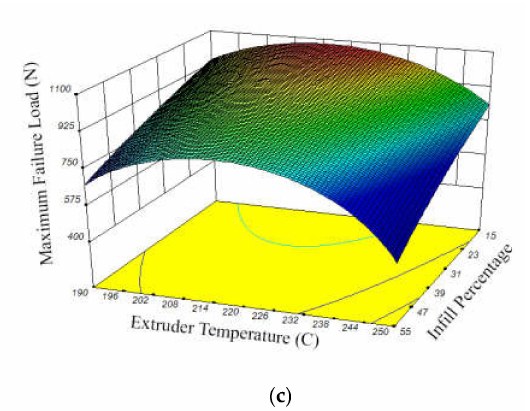
Figure 6. 3D surface plot of the maximum failure load with ( a ) infill percentage and layer thickness;